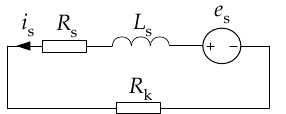
Figure 3. Equivalent circuit of short-circuit coil when short-circuit fault occurs.